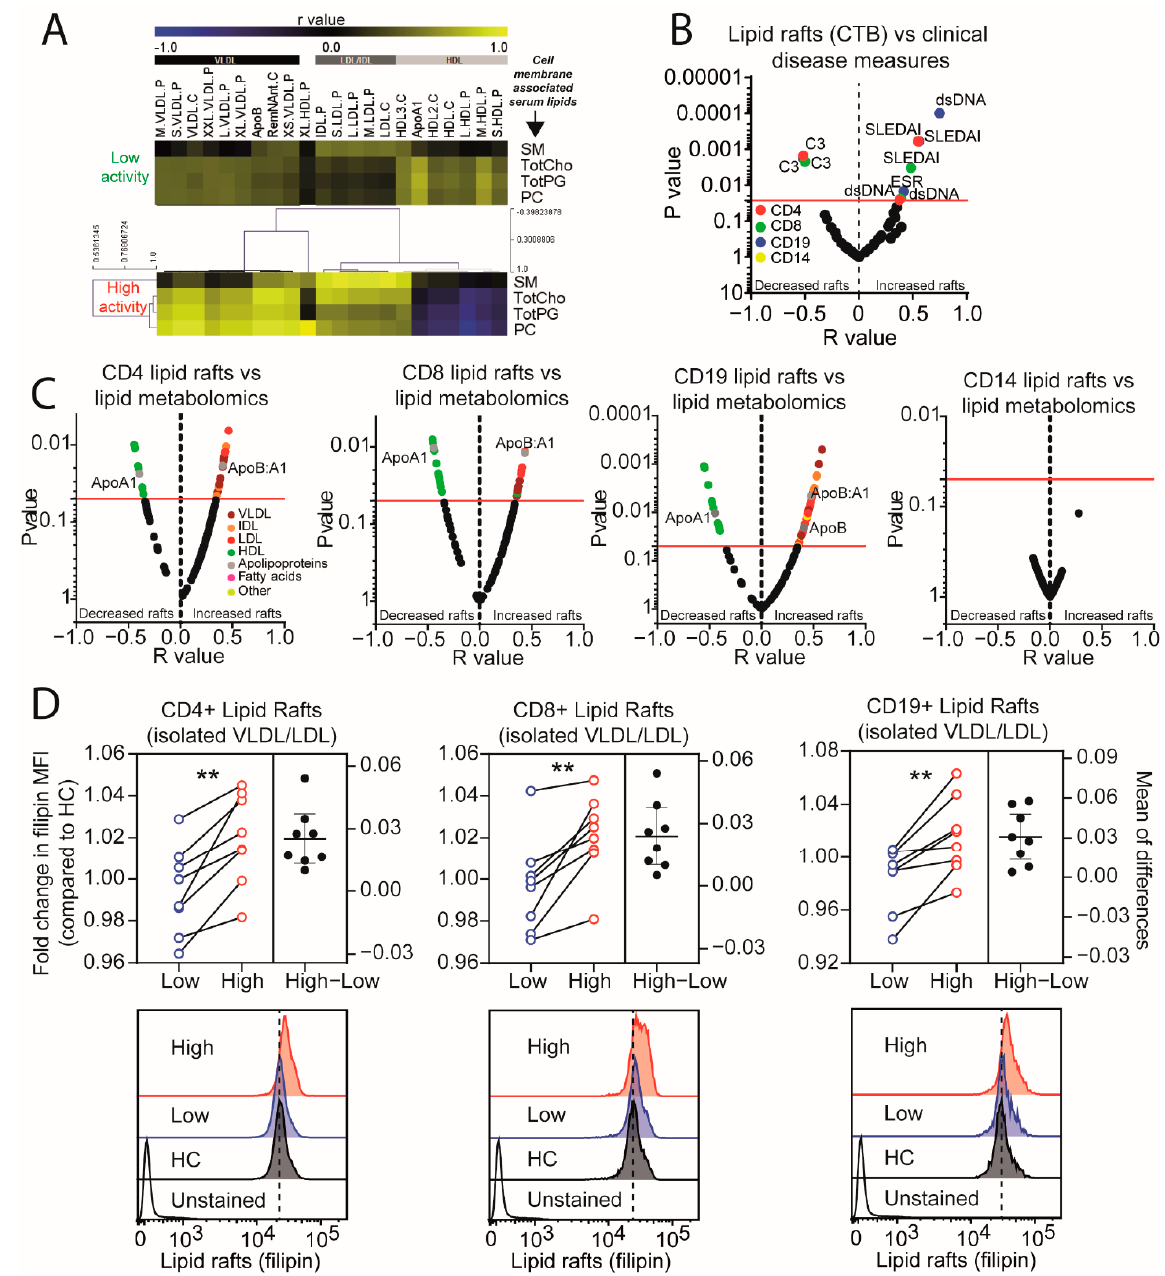
Figure 4. Lymphocyte inflammatory lipid signalling platforms are associated with disease activity and circulating lipoproteins in JSLE. ( A ) Heat map displaying r values (Pearson’s) of the correlation between lipoprotein particles (VLDL, very low-density lipoprotein; IDL, intermediate density lipoprotein; LDL, low density lipoprotein; HDL, high density lipoprotein), including apolipoproteins (ApoB and ApoA1), and serum lipids associated with lipid rafts: SM (sphingomyelin), TotCho (total cholesterol), TotPG (total phosphoglycerides), and PC (phosphatidylcholine and other cholines). ( B ) Volcano plot displaying the correlation (r-value, Pearson’s) of CD4+ and CD8+ T-cell, CD19 B-cell, and CD14 monocyte lipid raft expression (cholera toxin B, CTB; mean fluorescence intensity, MFI, measured ex vivo by flow cytometry) with clinical measures of disease activity (systemic lupus er- ythematosus disease activity index; SLEDAI, erythrocyte sedimentation rate; ESR, dsDNA; anti- double-stranded DNA antibodies, C3; complement protein 3) in JSLE patients ( n = 35). Log10 p val- ues displayed. ( C ) Volcano plot showing the correlation (r-value, Pearson’s) of CD4+, CD8+ T-cell, CD19 B-cell, and CD14 monocyte lipid raft expression with lipid metabolomic measures in JSLE